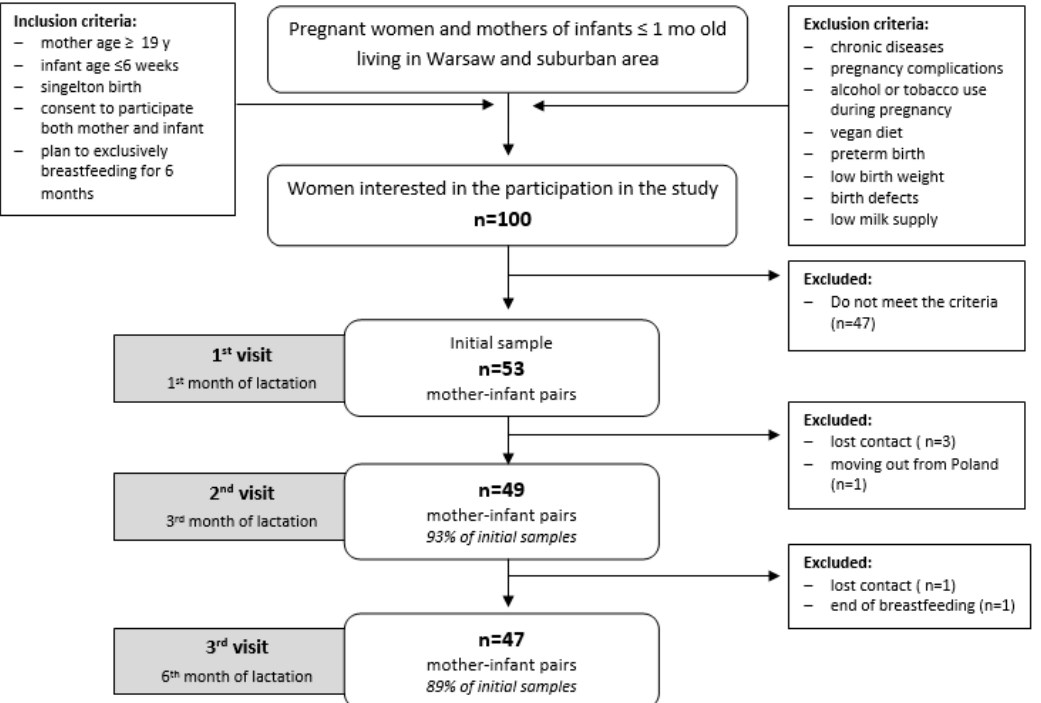
Figure 1. Flowchart: study design and study sample collection.